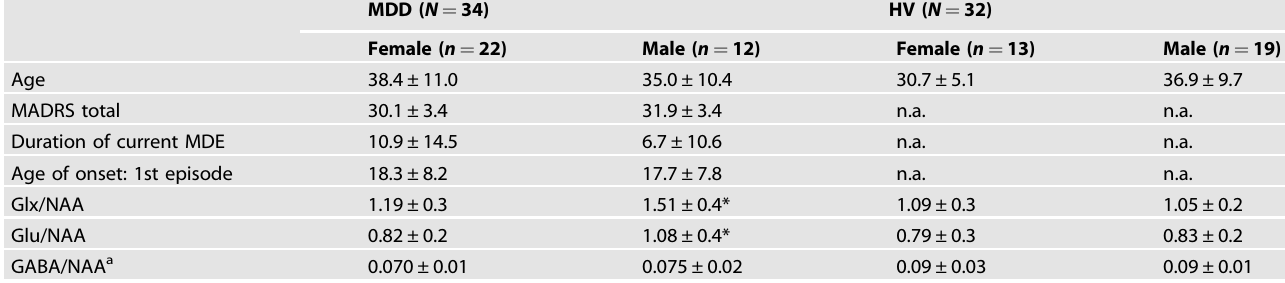
Table 2. Sex breakdown.